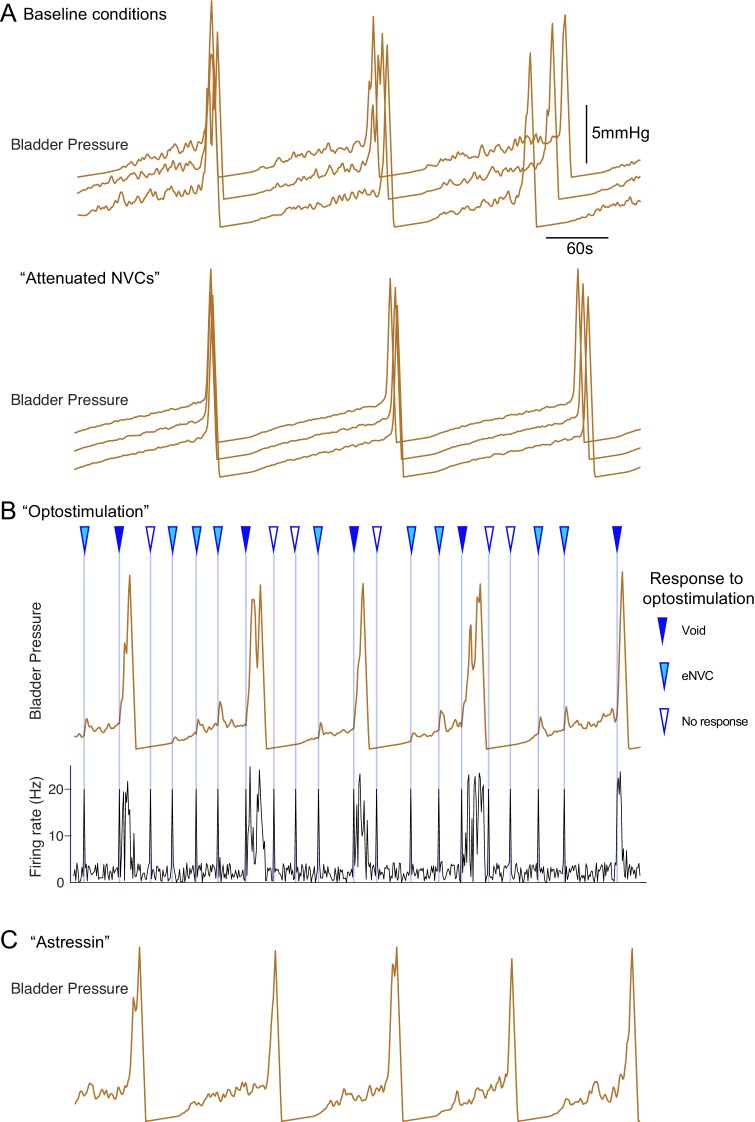
Inferential micturition model recapitulates observed behaviour.(A) Comparison of model outputs under basal conditions (upper panel, three consecutive runs) with a reduction in the variability in the BarrCRH firing (mean rates unchanged, lower panel). This attenuates the amplitude of the NVCs and delays the time to void indicating the importance of the NVCs in the micturition cycle. (B) Simulation of optogenetic activation of BarrCRH neurons (20 Hz x 1 s) at different points in the micturition cycle (all other model parameters as the basal condition in A). This external drive increased micturition frequency by triggering voids (when stimuli fell later in the filling cycle). Note that opto-activation earlier in the filling cycle generated NVCs of varying amplitude and also could lead to ‘failures’ with no bladder contraction. (C) A leftward shift in the mid-point (by 1 hz) of the spinal modulation sigmoid mimicked the effect of CRH antagonist astressin by increasing the excitability of the spinal circuit. This increased the amplitude of NVCs and increased micturition frequency (as compared to the basal condition shown in A).